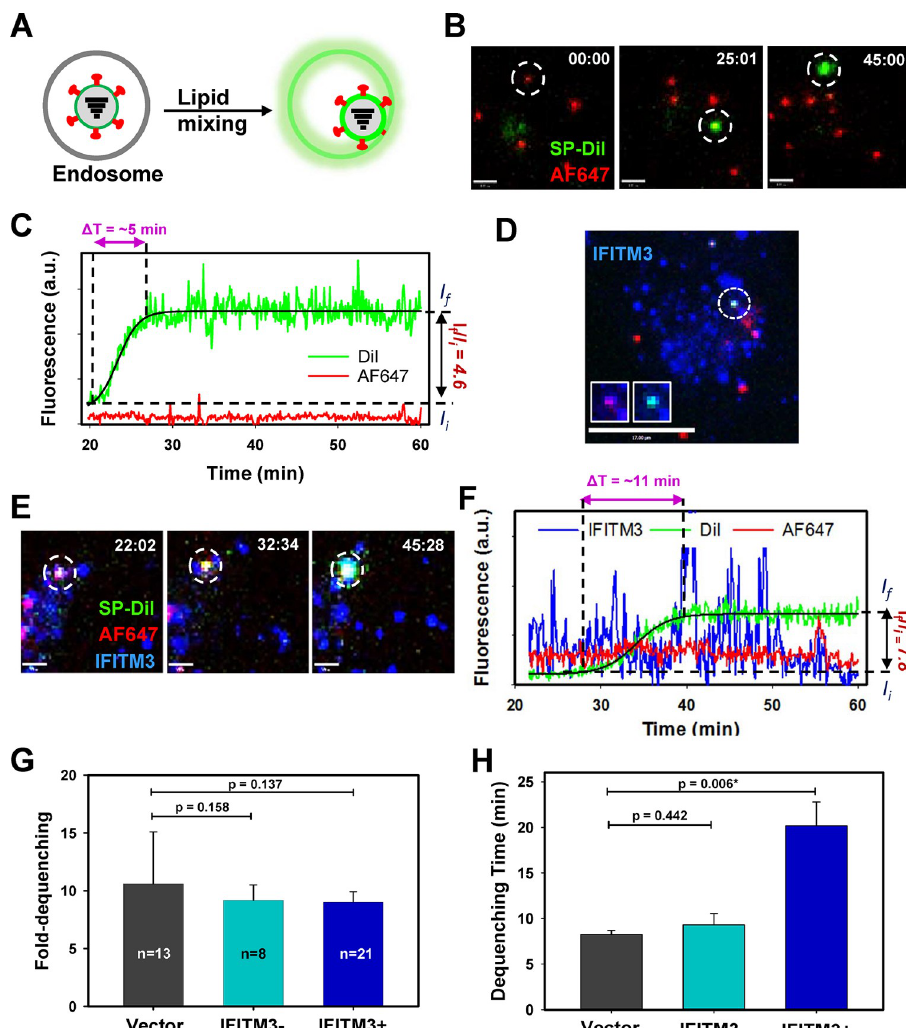
Fig 2. Fluorescent IFITM3 does not restrict IAV lipid mixing. (A) Schematic showing the single-virus hemifusion assay by monitoring dequenching of a lipophilic dye (SP-DiI 18 , colored green) resulting from lipid mixing between a virus and an endosome, yielding a green glow. HA was also fluorescently labeled (red), allowing it to be independently tracked. (B) Time series images show dequenching of SP-DiI 18 upon entry of IAV co-labeled with AF647 (red) into A549 Vector cells. Scale bar 4 μ m. (C) Fluorescence traces for the single IAV hemifusion event in (D) showing an increase in intensity of SP-DiI 18 while the reference AF647 signal remains constant. The time for complete dequenching ( Δ t) and the dequenching ratio of final and initial mean intensities ( I f / I i ) are shown for this trace. (See S1 Movie.) (D) A549 cells stably transduced with IFITM3-imNG (IFITM3, blue) were monitored by time-lapse imaging, which shows SP-DiI 18 dequenching as a result of lipid mixing between IAV and an endosome. Scale bar 17 μ m. (See also S2 Fig) (E) Time series images show dequenching of SP-DiI 18 upon entry of IAV co-labeled with AF647 with an endosome containing IFITM3-imTFP1. (F) Fluorescence traces for the single IAV lipid mixing event shown in (E). (See S3 Movie). (G) The average ratios of final (post-dequenching) and initial mean intensities ( I f / I i ) are shown from at least three independent experiments in A549 Vector and A549-IFITM3-imNG cells. Lipid mixing events were categorized based on whether they colocalized with IFITM3-imTFP1 puncta (IFITM3+) or occurred in the areas devoid of IFITM3-imNG signal (IFITM3-). Average ratios are plotted with standard errors. There are no significant differences in A549 Vector and IFITM3- average dequenching ratios or in A549 Vector and IFITM3+ endosomes. (H) The average dequenching times and standard errors are shown for A549 Vector, IFITM3- and IFITM3+ endosomes. The dequenching time between A549 Vector and IFITM3-negative endosomes was not significantly different, but lipid mixing was significantly slower in IFITM3+